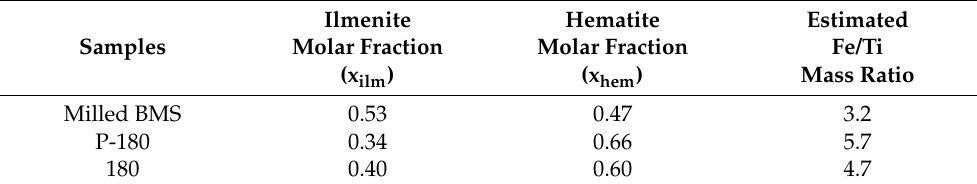
Table 3. Ilmenite and hematite molar fractions within the ilmenite-hematite solid solution, obtained by XRPD, in milled BMS, and P-180 and 180 powders, together with estimated Fe/Ti mass ratios. Estimated Hematite Ilmenite Fe/Ti Molar Fraction Samples Molar Fraction Mass Ratio (x hem ) (x ilm ) Milled BMS